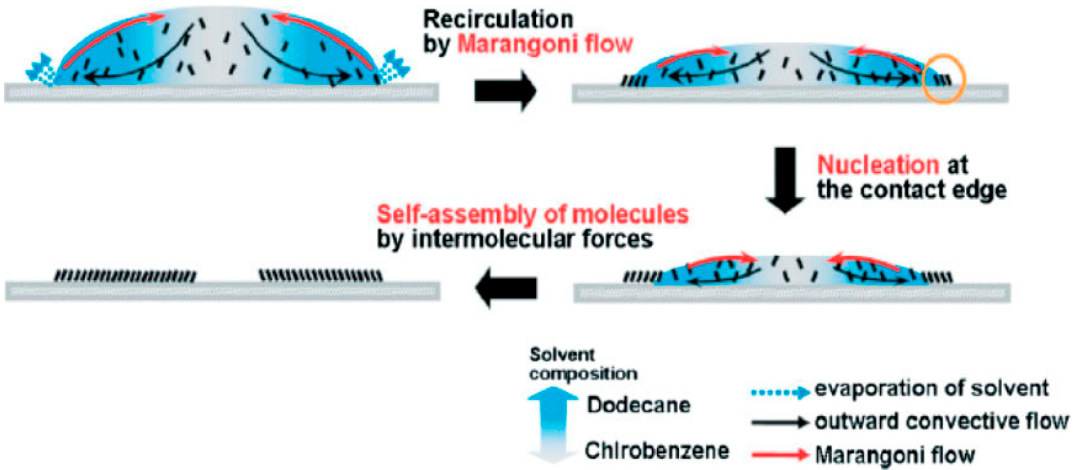
Figure 2. Schematic representation of the potential drying process and crystal formation of an organic semiconductor, 6,13-bis((triisopropylsilylethynyl) pentacene (form 25% dodecane) after deposition from a drop-on-demand piezoelectric print head [36].